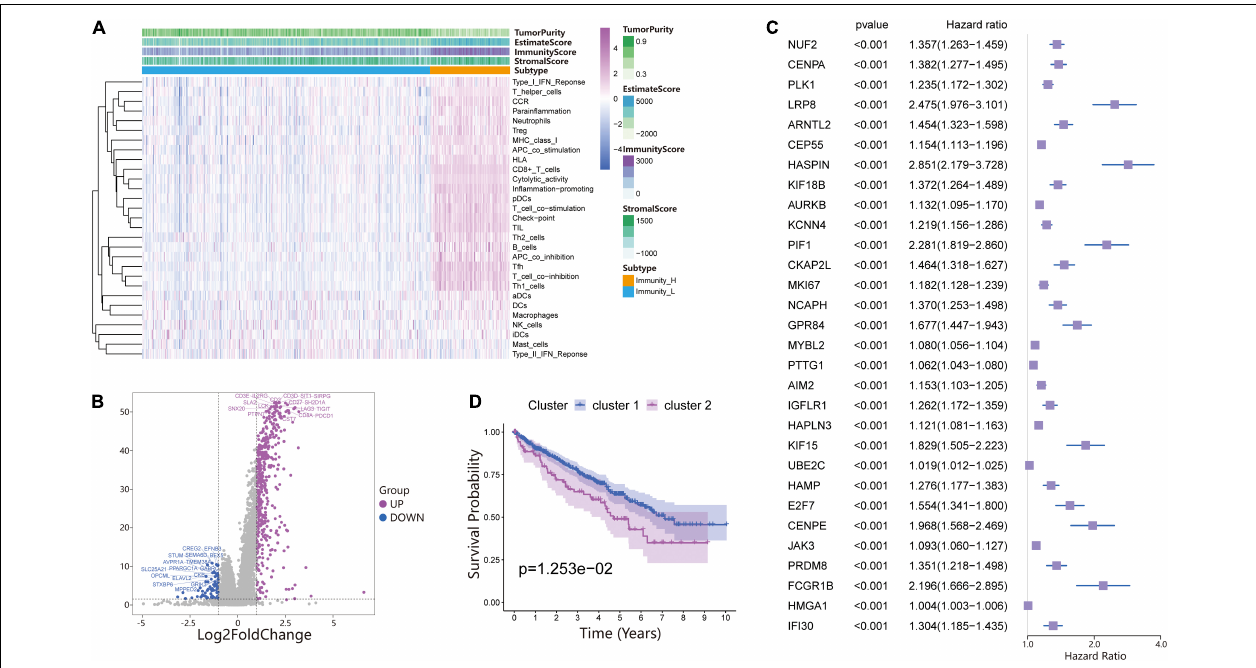
FIGURE 1 | Investigation of the immune infiltration-dependent expression change in clear cell renal cell carcinoma (ccRCC). (A) Twenty-nine immune-related gene sets were enriched in ccRCC. These genes comprised immune cells and immune processes. The tumor purity, estimates, immunity scores, and stromal scores are also shown in the heatmap. Immunity High: Immunity_H, Immunity Low: Immunity_L. (B) Volcano plot of 514 genes differentially expressed between Immunity_L and Immunity_H. Purple dots and blue dots represent upregulated and downregulated genes, respectively. The screening criteria were | log2FC| > 1.0 and p -value < 0.05. (C) Univariate Cox regression analysis was used to screen genes significantly associated with prognosis with a p -value < 0.01. The top 30 genes are shown in the forest map. (D) Survival analysis of Cluster 1 and Cluster 2. In Cluster 1 and Cluster 2, the Kaplan–Meier curve with a log-rank p -value of 0.013 showed significant survival